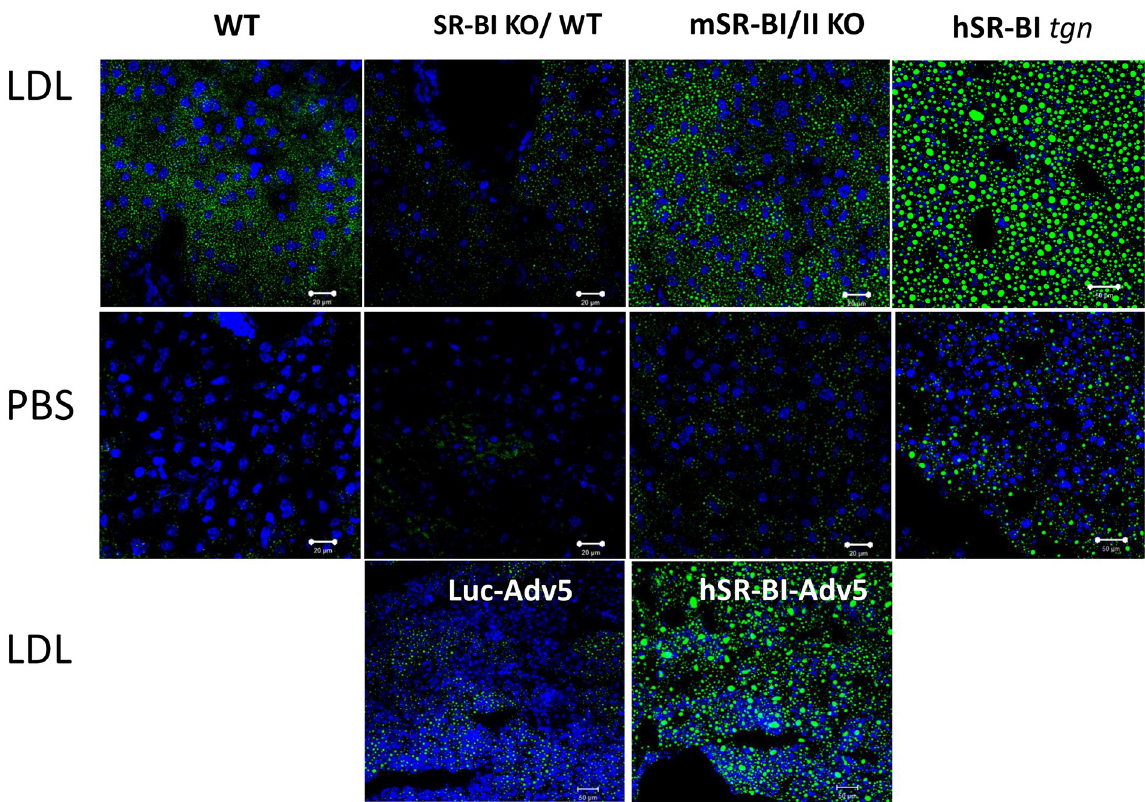
Fig 12. LDL-lipid accumulation in the livers of various mice. Mice were fasted overnight and injected IV with either PBS (middle panel) or 2 mg of human LDL (upper and lower panels) and sacrificed 2 hours later. The upper two rows of panels show LD staining in liver cryosections from normal, SR-BI/II KO, hSR-BI transgenic SR-BI/II KO and hSR-BI transgenic normal mice after (+) or without (-) an LDL injection. The lower panels show LD staining in liver cryosections of Luc-AdV5 and SR-BI-AdV5 treated SR-BI KO mice following LDL injection. The animal codes are written on the panels. The bar corresponds to 20 μ